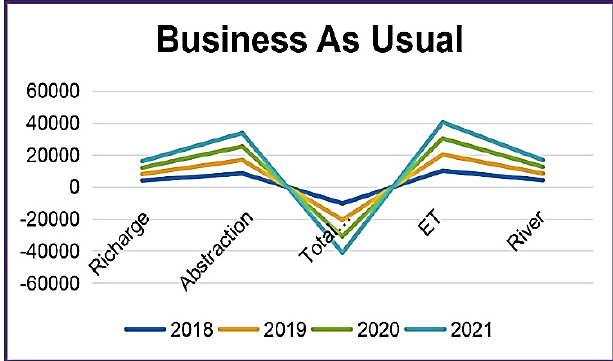
Figure 6: GW abstraction is same as Canal water Supply